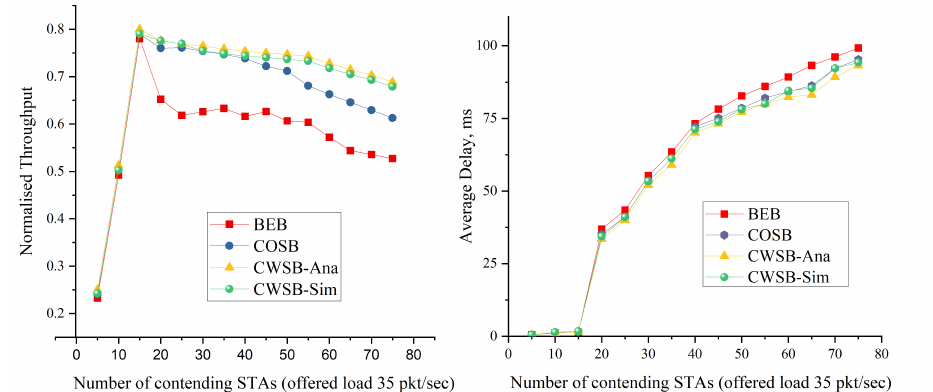
Figure 10. Calculated normalised throughput and average delay under an unsaturated traffic environ- ment.